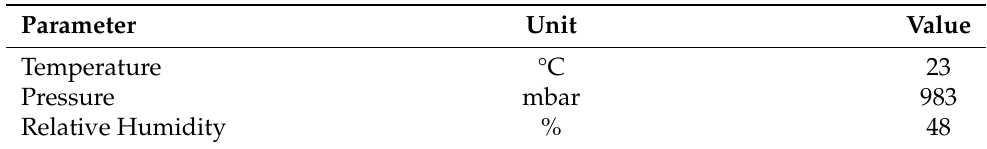
Table 2. Ambient air conditions during measurements at the test stand.